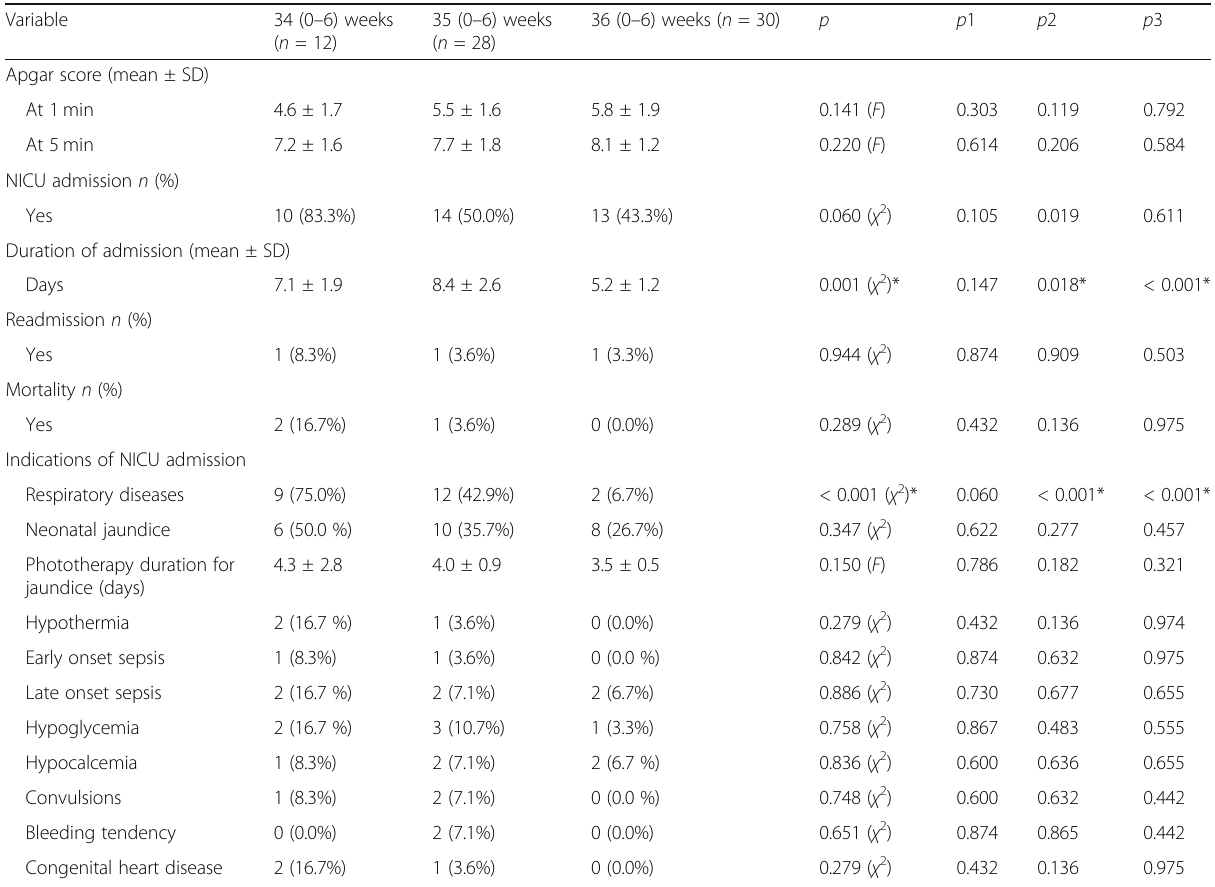
Table 5 Indication for NICU admission in LPT subgroups